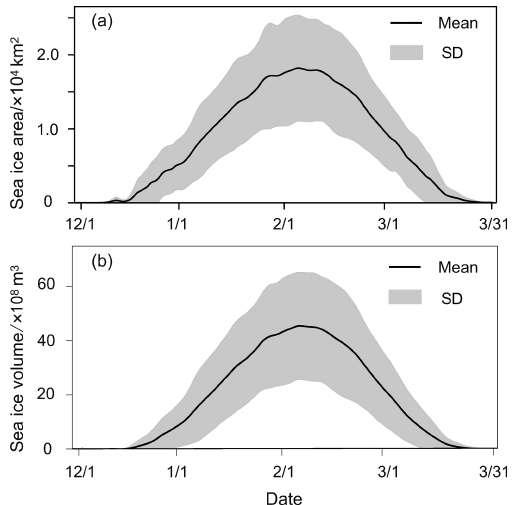
Figure 15. Seasonal cycles of daily sea ice area (a) and sea ice volume (b) in the Bohai Sea. The lines show the daily averages, and the shading denotes 1 standard deviation. The seasonal cycles are calculated for the periods 1996–2017.